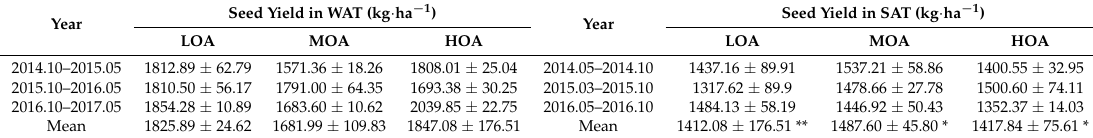
Table 4. Seed yield of cultivars with LOA, MOA, and HOA in WAT and SAT for three years.